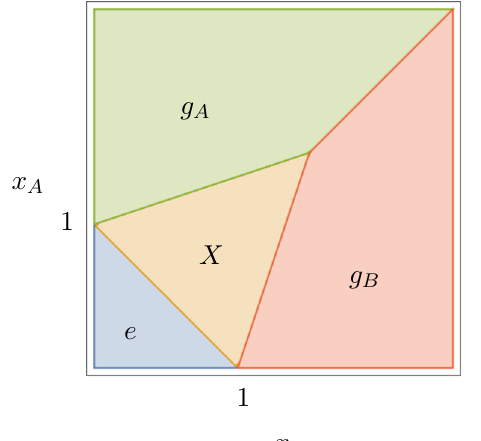
Figure 8 . A graphical representation of the special element X , using the same conventions as figure 5.